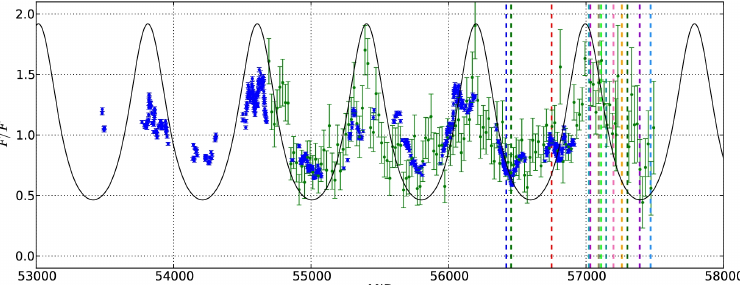
Figure 10. The ∼ 9 y-long light curve of PG 1553+113 in HE gamma-rays (20-d bins; green points) and in the optical (blue points) band. The black line shows the periodicity model, and the vertical line corresponds to some spectrum calculations. From